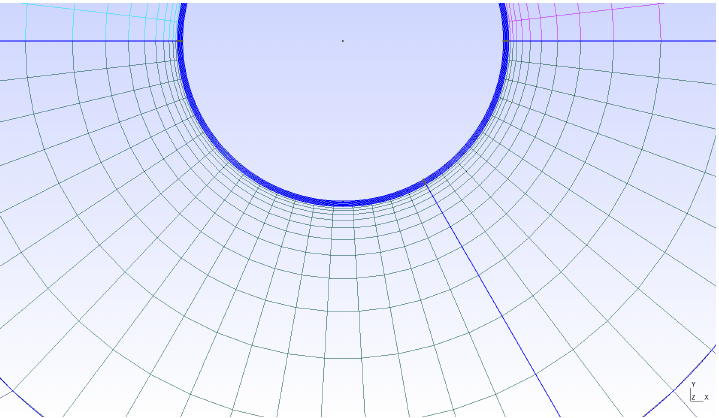
Figure 4. Close-up view of the mesh next to the cylinder. It is worth noting that this mesh has not yet received p-type refinement ( N p = 2), that is, in this case, in each direction the elements still will be “divided” in half, increasing their